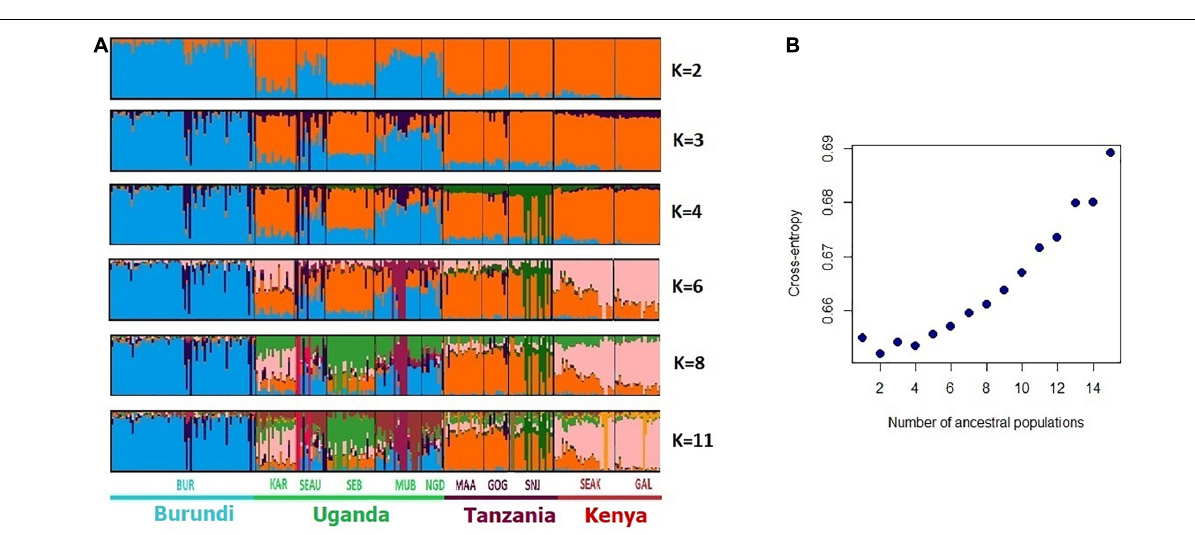
FIGURE 4 | Bayesian clustering performed with ADMIXTURE software on the East African goats. (A) Display for different values of K , with K = number of clusters; (B) cross-entropy plot for the number of cluster K =